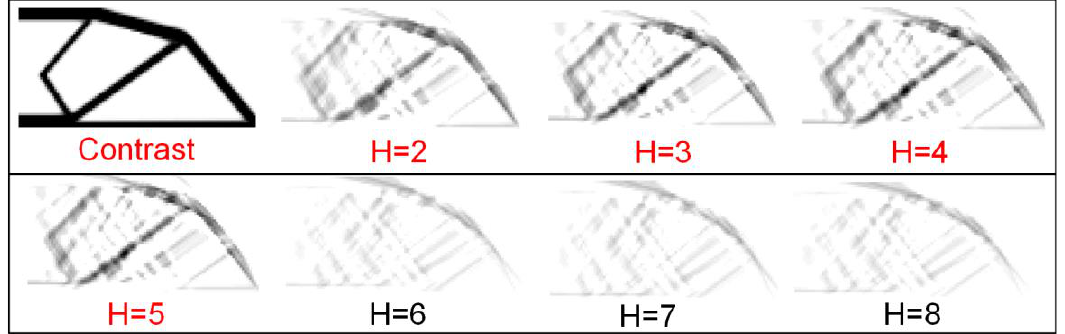
Figure 9. The prediction result of training 3 with different H.